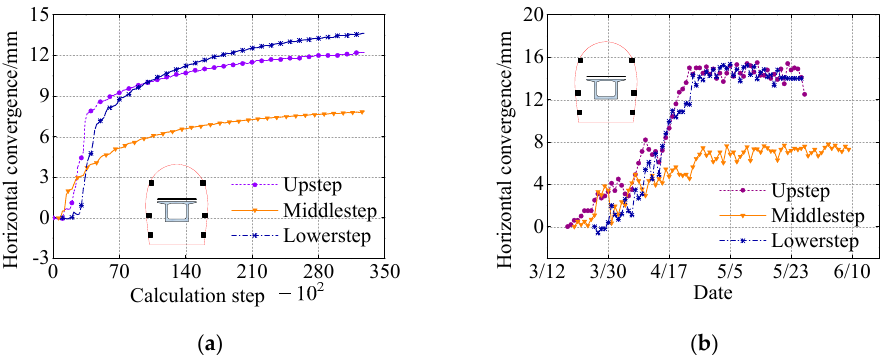
Figure 6. Horizontal convergence of II-type tunnel ( a ) numerical simulation result ( b ) Field monitor result.